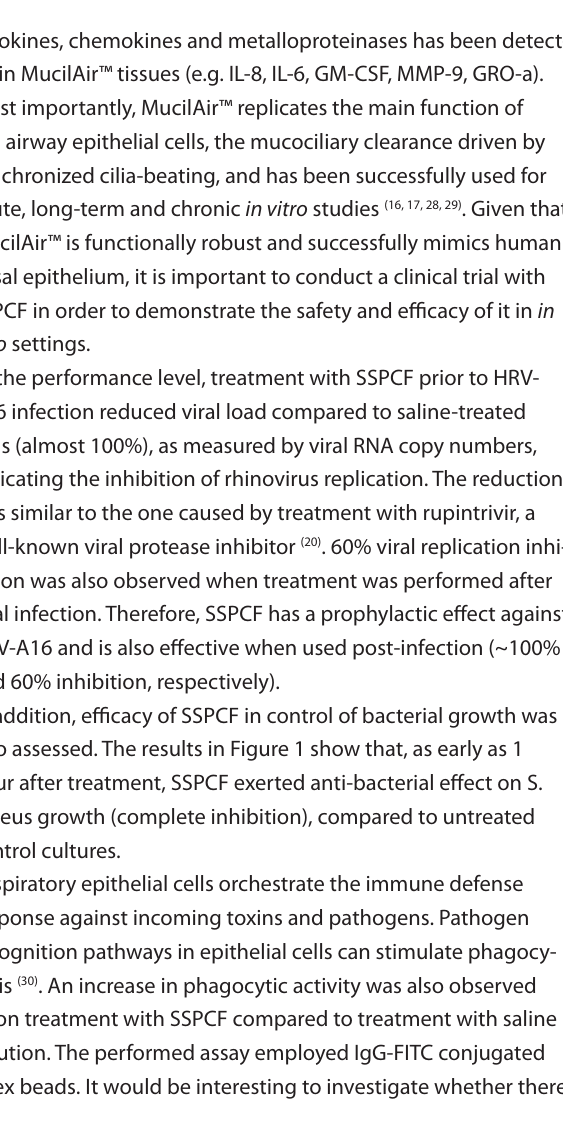
Figure 3. Phagocytic activity after SSPCF pre-treatment. A, Representative fluorescent images of cells derived from MucilAir™ tissues with internalized fluorescent beads after 1-hour treatment. B, Quantification of data in (A). ***p < 0.001 compared to saline